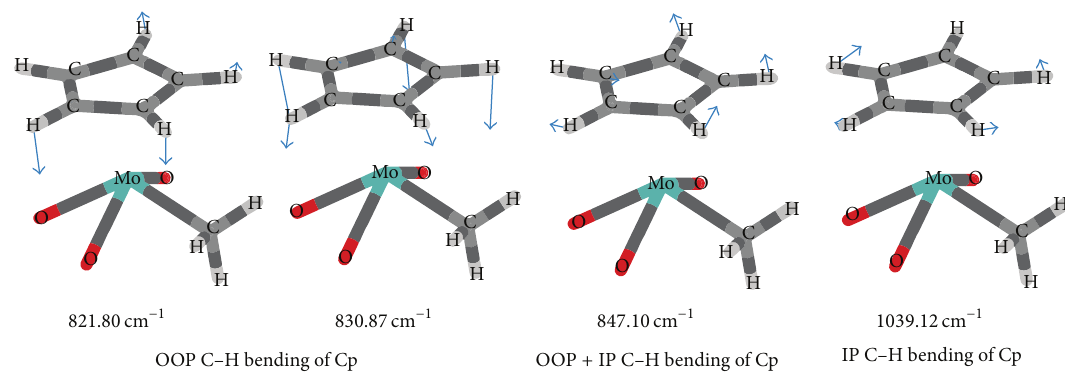
Figure 3: 800–850 cm −1 bending modes that are associated with the Cp ring for 1-C2